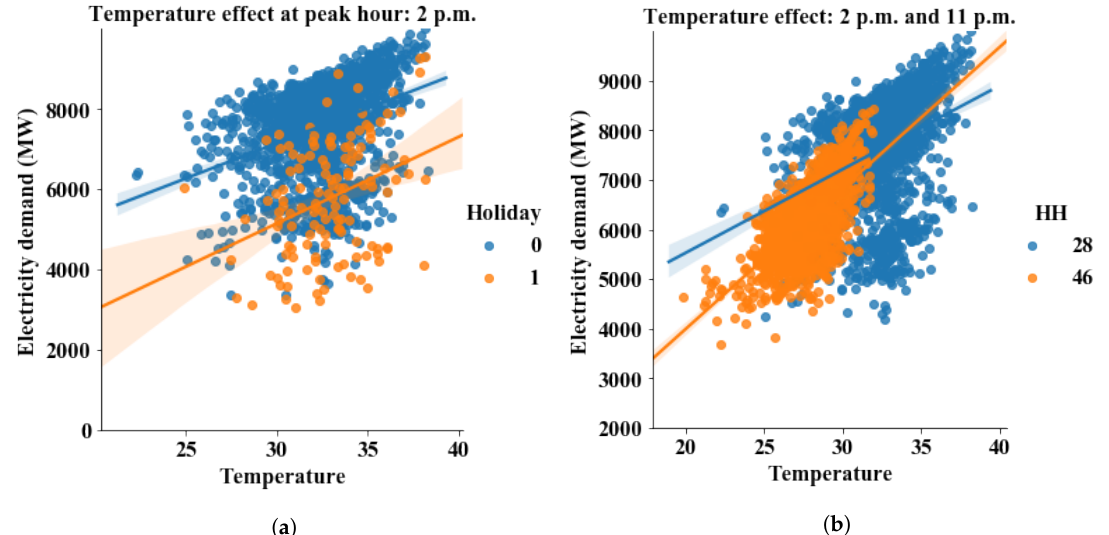
Figure A5. ( a ) Effect of temperature during peak hour. ( b ) Effect of temperature at two different hours.